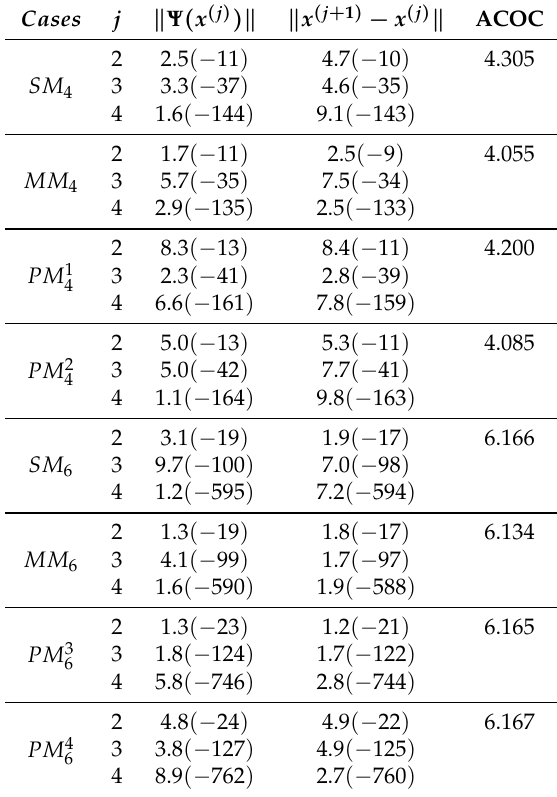
Table 2. Comparative study of different methods for Example